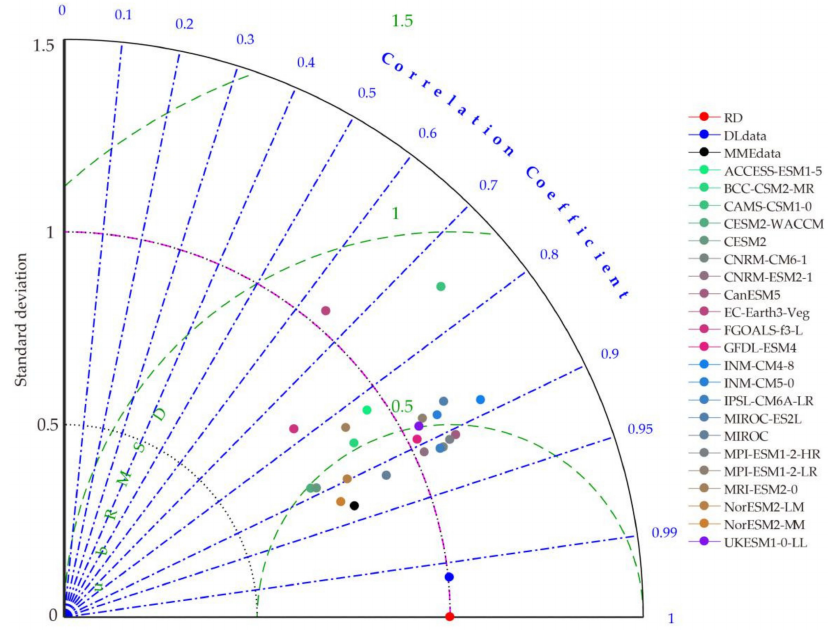
Figure 4. The Taylor diagram of the monthly DL merged data, MME data and single GCM data in the period of the test dataset (2008–2014). The Y axis shows the standard deviation (STD), ubRMSD is depicted by the green circles with dashed lines and the angular coordinate is applied to represent R.